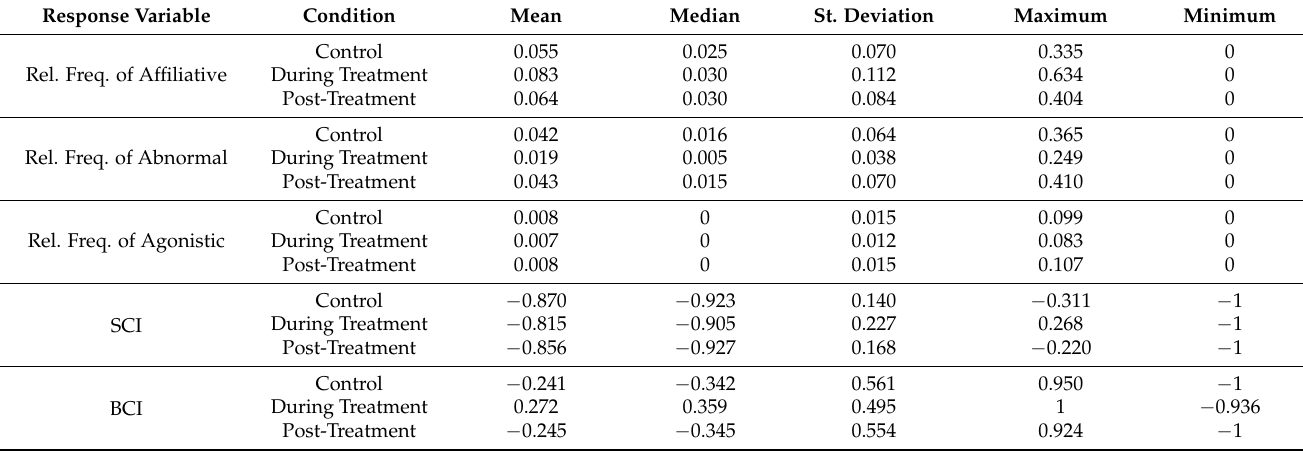
Table 3. Descriptive statistics for each response variable, grouped by condition, regarding the behaviour of the chimpanzees at Tacugama Chimpanzee Sanctuary (data collected from November 2019 until March 2020). Response